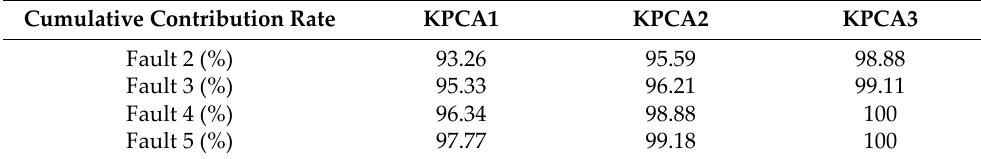
Table 6. Cumulative contribution rate.